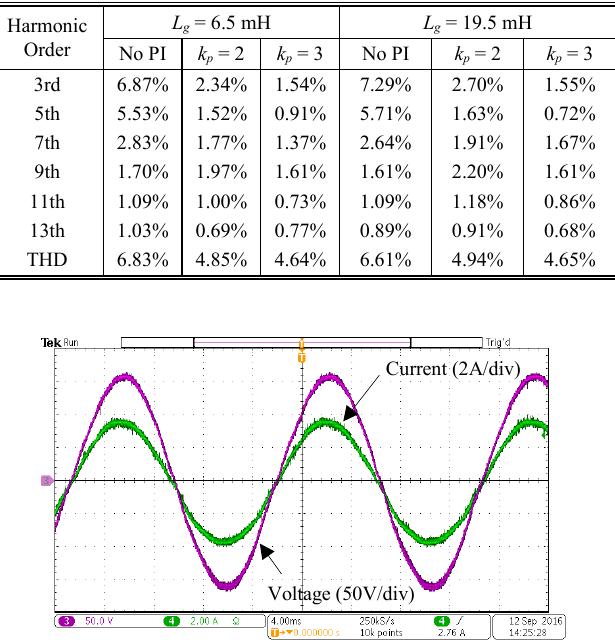
Fig. 16. Output voltage and output current when L g = 19.5 mH ( τ i = 0.0005)